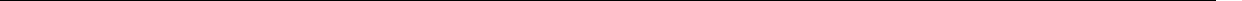
Fig. 4 Ala57 allows the mobility of the H3mm7 nucleosome. a T32I and S57A are only the differences between H3.3 and H3mm7. N-terminals of the amino acid sequence of H3.3 and H3mm7 are shown in the illustration of the secondary structure. b High-resolution crystal structure of an H3mm7-containing nucleosome shows the loss of interaction between H3.3S57 and H4R40 in the H3mm7 nucleosome. An overview of the crystal structure of the H3mm7- containing nucleosome (left) and the comparative view around S57 in H3.3 and A57 in H3mm7 (right). c H3mm7 nucleosomes were dissociated at a concentration of 600 mM NaCl. The salt-titration assay of H3mm7, H3.3, and the mutant (H3.3S57A and T32I) containing nucleosomes is shown. The positions of the bands that correspond with the intact nucleosome core particle and naked DNA are indicated on the right. d H3.3S57A and H3mm7 dissociated from the H2A:H2B dimer faster than the other H3 variant-containing nucleosomes. Thermal stability assay of H3mm7, H3.3, and the point mutants H3.3T32I and H3.3S57A. The lines show the fl uorescent intensity that indicates nucleosome dissociation at each temperature. The error bars are ± 1 SD ( n = 4). e H3mm7 and H3.3S57A showed a fast histone turnover. FRAP analysis of nucleosomes containing GFP-fused H3mm7, H3.3, and the point mutants. Representative confocal images of FRAP analysis in each H3 variant nucleosome is shown on the left. Plot of average GFP fl uorescent recovery rate at each time point after photobleaching is shown on the right. The error bars are ± 1 SD. The number of replicates is indicated in